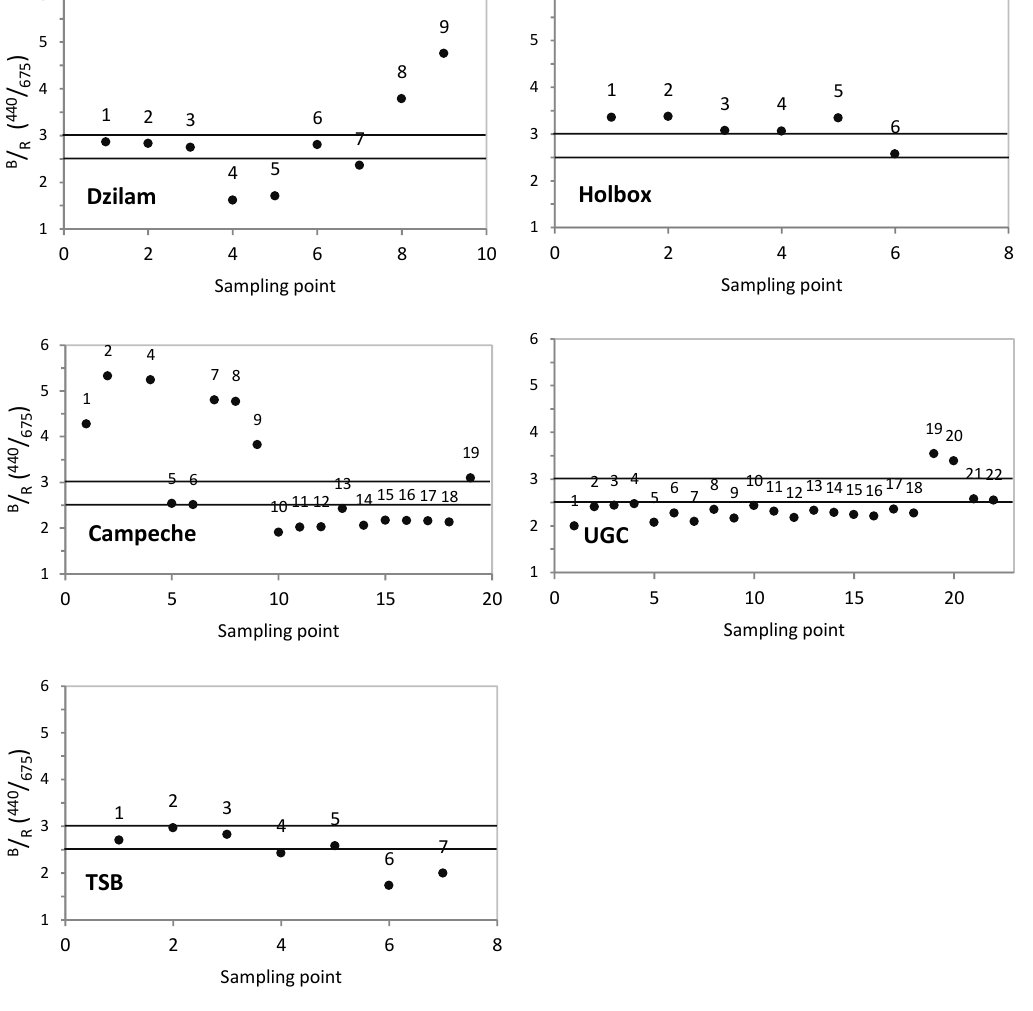
Figure 6. Blue/red ratio (B/R) index for each sampling campaign and sampling point. From top to bottom and from left to right: Dzilam, Holbox, Campeche Bay, Upper Gulf of California (UGC) and Todos Santos Bay